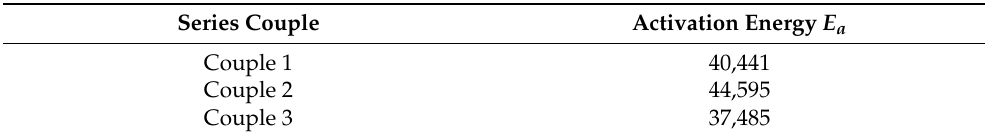
Table 4. Activation energy E a for OC-C30/37.